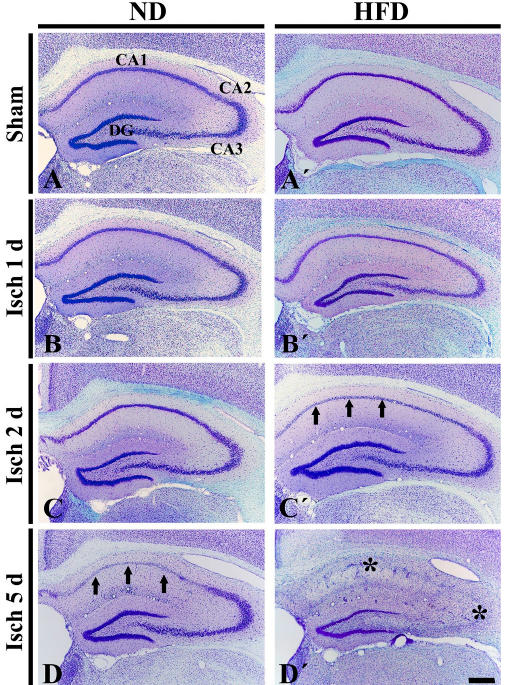
Figure 1. CV staining in the hippocampus of the ND-fed (left column) and HFD-fed (right column) groups at sham ( A , A ’), 1 day ( B , B ´), 2 days ( C , C ´) and 5 days ( D , D ´) after tGCI. In the ND-ischemia group, CV + cells are pale (damaged) in the CA1 area (arrows) 5 days after tGCI. In the HFD-ischemia-group, damaged CV + cells in the CA1 area (arrows) is shown 2 days after tGCI, and, 5 days after tGCI, severely damaged CV + cells are shown in the CA2/3 area (asterisk) as well as CA1 area (asterisk). DG, dentate gyrus. Scale bar = 400 μ m.